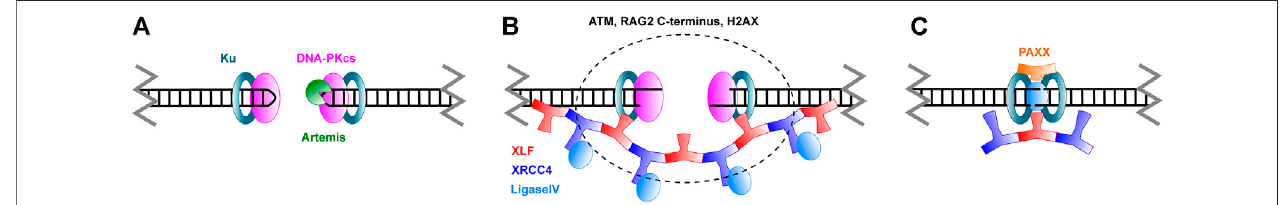
FIGURE 4 | Schematic overview of Non-Homologous End Joining. (A) Broken DNA ends are recognized by Ku and DNA-PKcs. Hairpins in coding ends are opened by the Artemis nuclease. (B) Ends are brought in close proximity in a process called synapsis. XLF and XRCC4 are thought to form fi laments that mediate this process.Asdiscussed inthetext, ATM,theRAG2C-terminusand H2AXalso havearoleinsynapsis. (C) Endsareligated byLigaseIV.PAXX joinsinthisstageofrepair. Please note that, while care was taken to represent the architecture of the complexes as accurately as possible, many structural features still remain unknown.